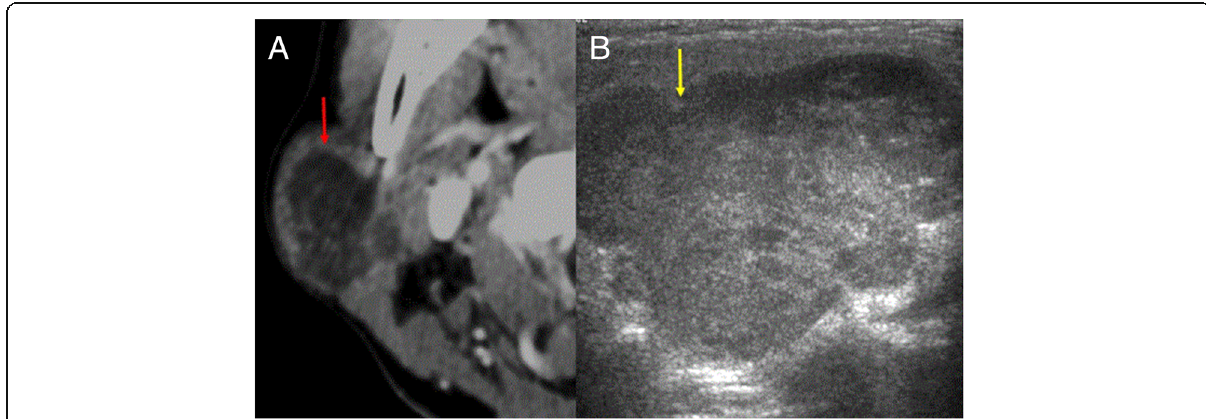
Fig. 3 Well-defined lobulated mass in the right parotid gland. A Post-contrast CT axial image shows a lobulated low-density mass in the right parotid gland which mimics a cystic lesion suggesting benign neoplasm (red arrow). B U/S shows homogeneously solid and shows well-defined lobulated margins (yellow